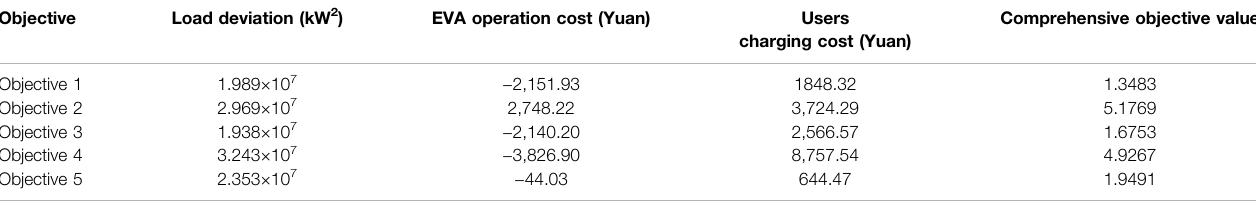
TABLE 4 | Results of different optimization objectives. Objective